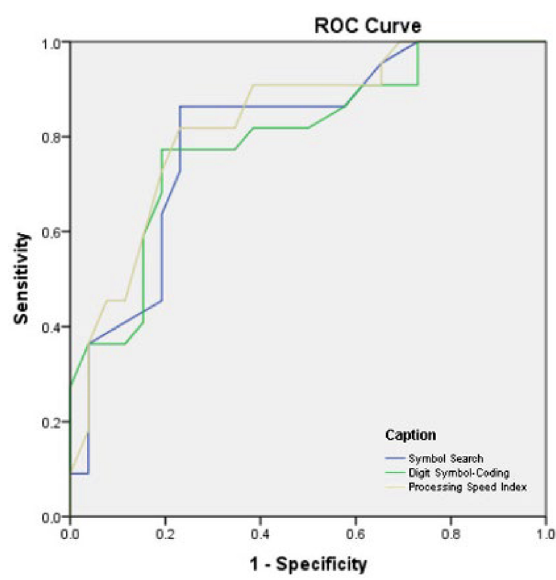
Figure 3. Analyses of Receiver Operating Characteristic curve, sensitivity, and specificity for individuals with mild cognitive impairment versus control participants.